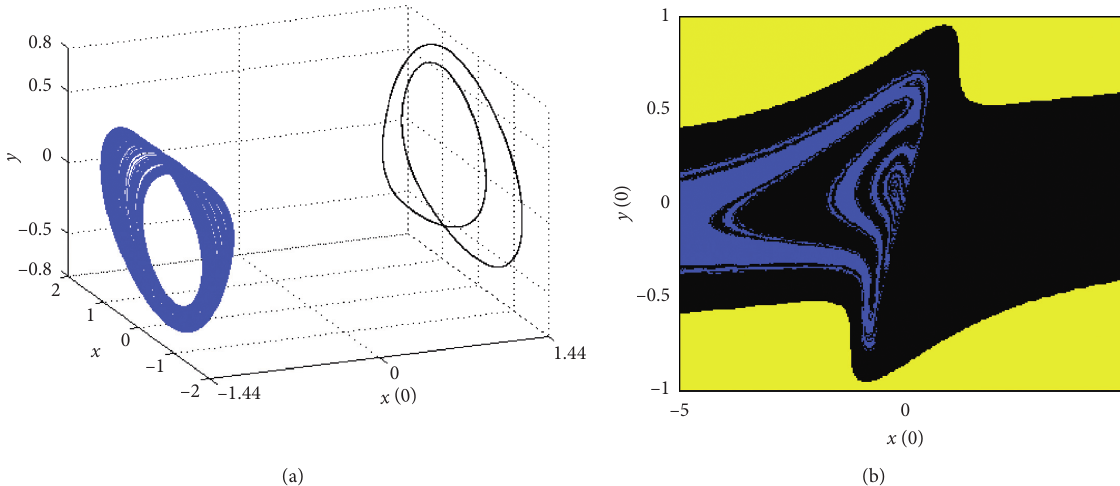
Figure 7: (a) Coexistence of an asymmetric chaotic attractor with a asymmetric periodic-2 limit cycle showing multistability phenomenon with the basin of attraction (b) in the plane ( x ( 0 ) , y ( 0 )) when δ � 0 . 3.